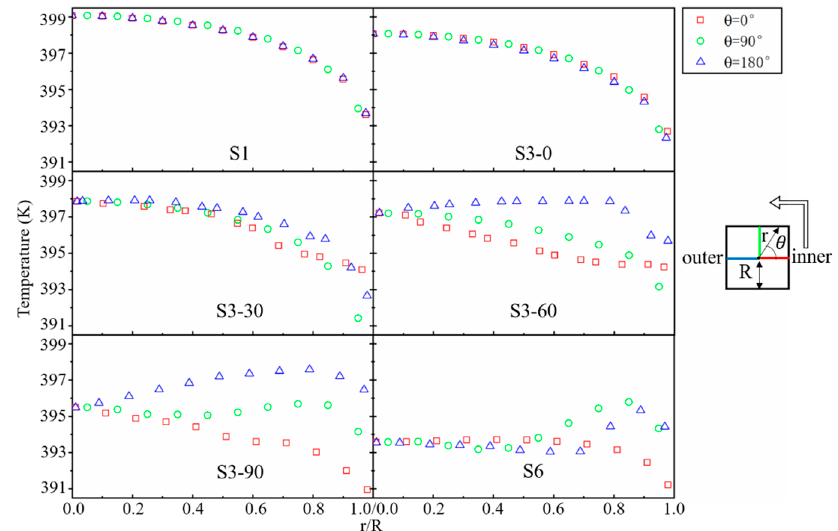
Figure 14. Time-averaged temperature profiles along different radial lines located at 90° intervals starting from θ = 0°.